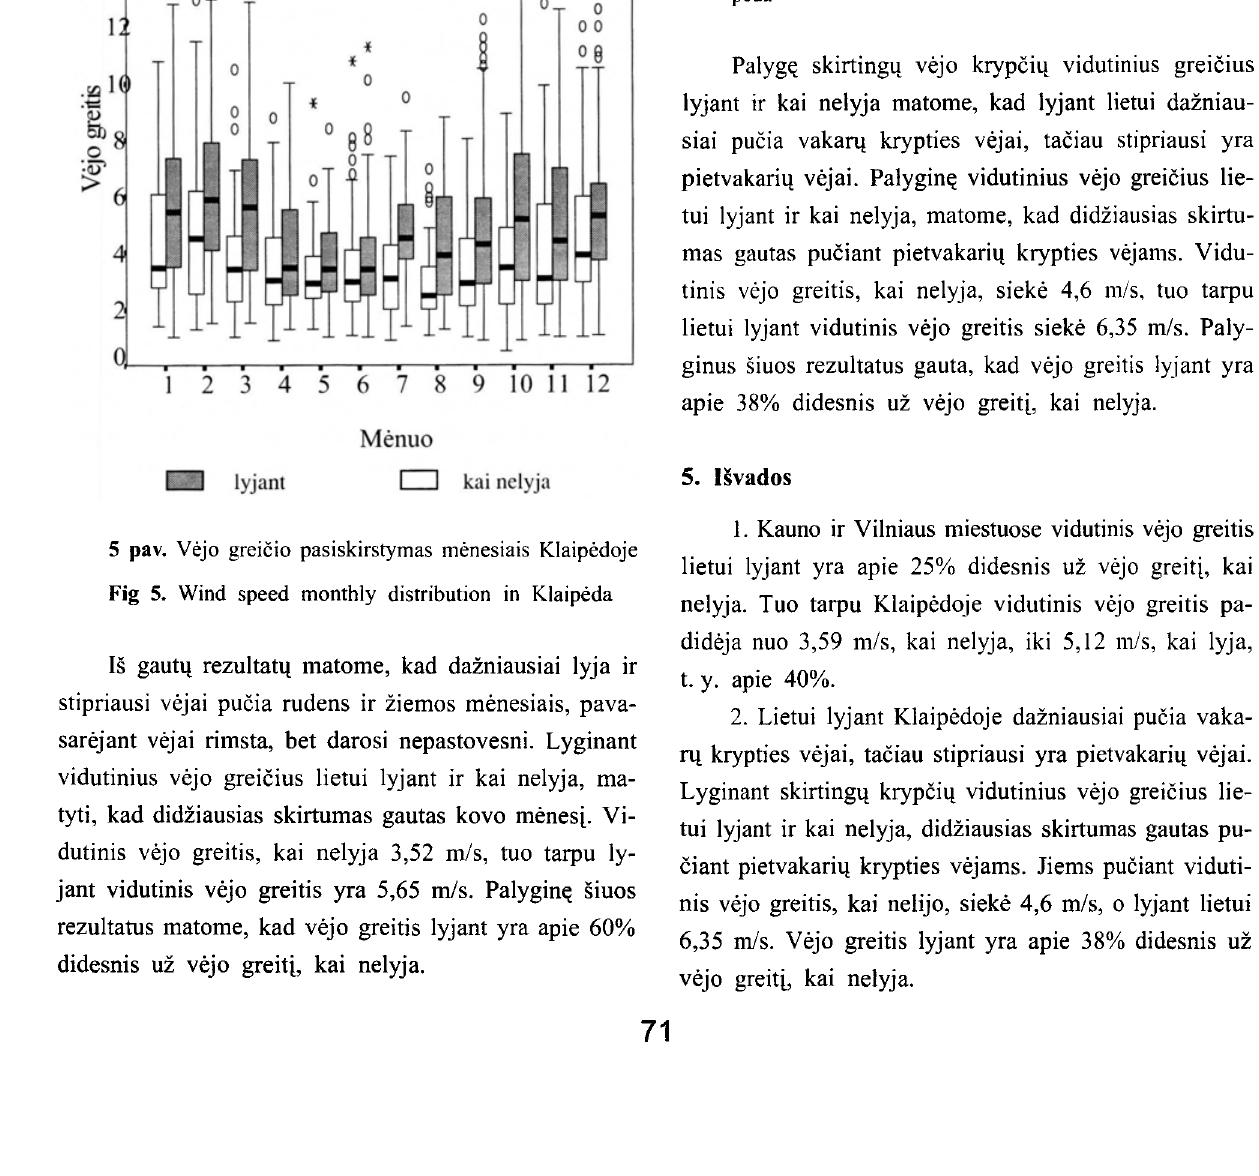
Fig 6. Different direction wind speed distribution in Klai peda Palyge; skirtingq vejo krypCi4 vidutinius greicius lyjant ir kai nelyja matome, kad lyjant lietui dazniau siai pucia vakarq krypties vejai, taciau stipriausi yra pietvakari4 vejai. Palygine; vidutinius vejo greiCius lie tui lyjant ir kai nelyja, matome, kad didziausias